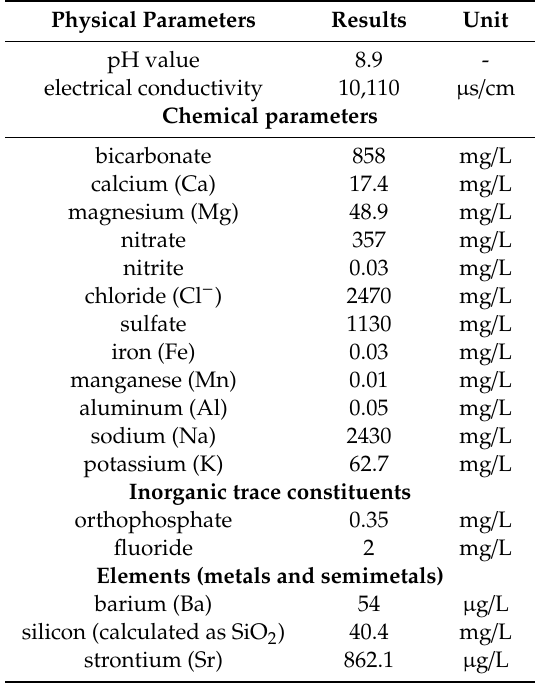
Table 2. Composition of the synthetic RO brine